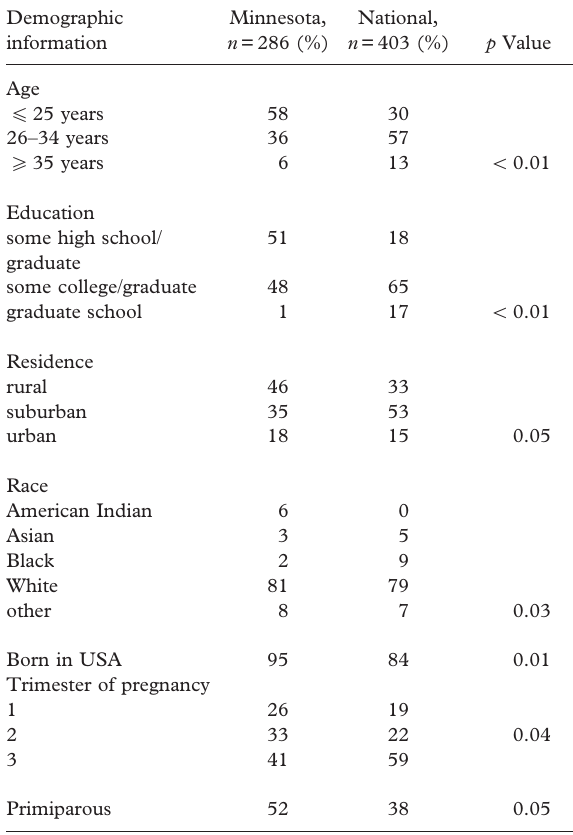
Table I. Demographic characteristics of participants.